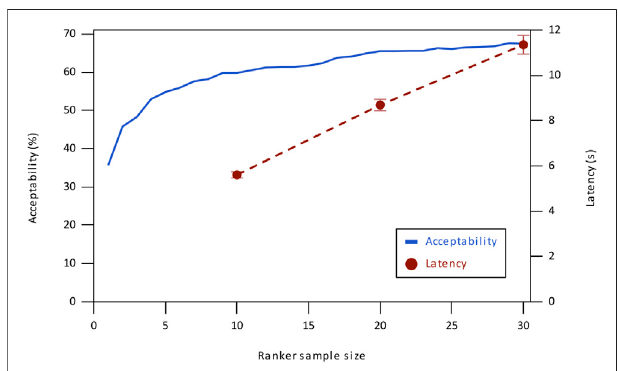
TABLE 8 | Mean acceptability of story continuations in the test set. System untuned